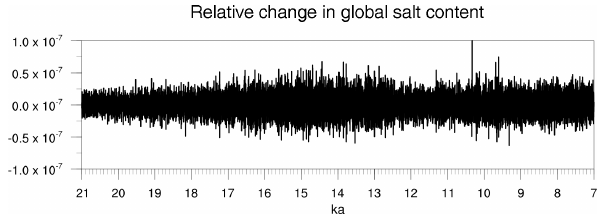
Figure 10. Relative change of the yearly mean global salt content during the test run with MPI-ESM.